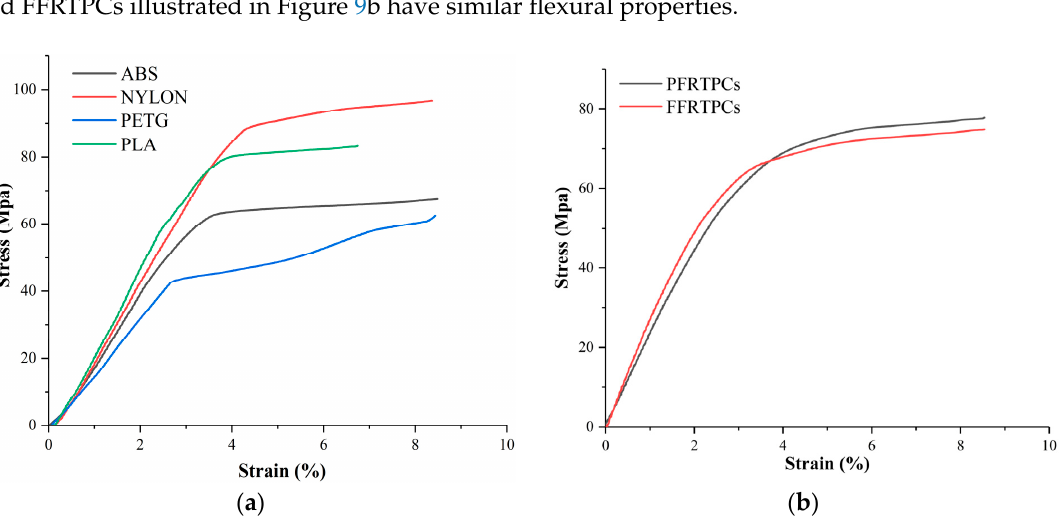
Figure 9. Stress-strain diagram of flexural test. ( a ) Stress-strain diagram of referenced pure polymers. ( b ) Stress-strain diagram of fiber-reinforced polymers.